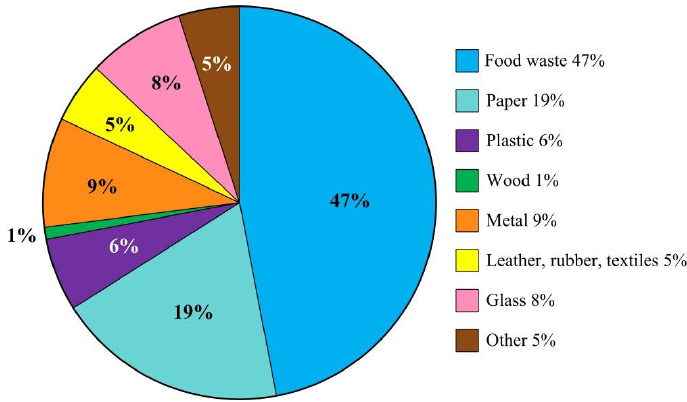
Figure 9. MSW structure of Tomsk region (No. 3).